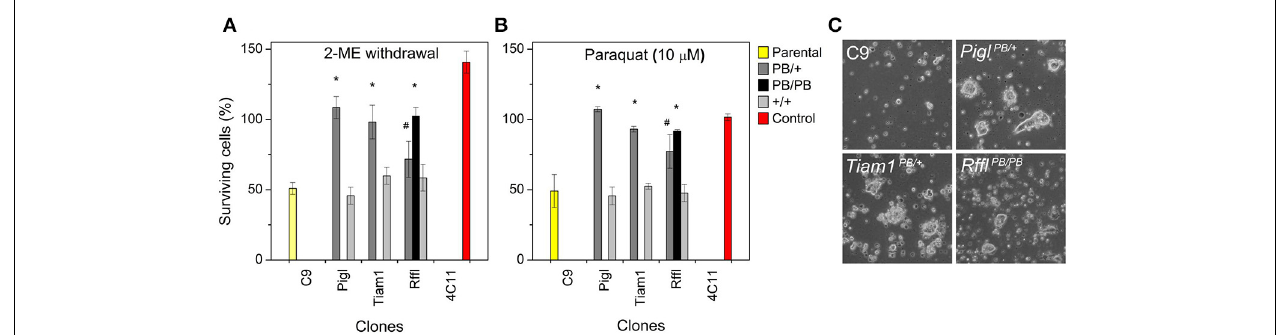
FIGURE 3 | Stress resistance in mutant ES cells. (A) Resistance to 2-mercaptoethanol (2-ME) withdrawal. (B) Resistance to paraquat (PQ). Shown are the parental wild-type ES cells (C9: yellow), a stress-resistant control ES cell clone, (4C11: red), recovered from a previous study (Chick et al., 2009), and three gene-trap clones (gray). Cells were subjected to stress treatment for two days, after which the number of viable cells was counted. Pigl , Tiam1 , and Rffl heterozygotes (PB/ + : dark gray) exhibit resistance to both of these stressors. Rffl homozygotes (PB/PB: black)